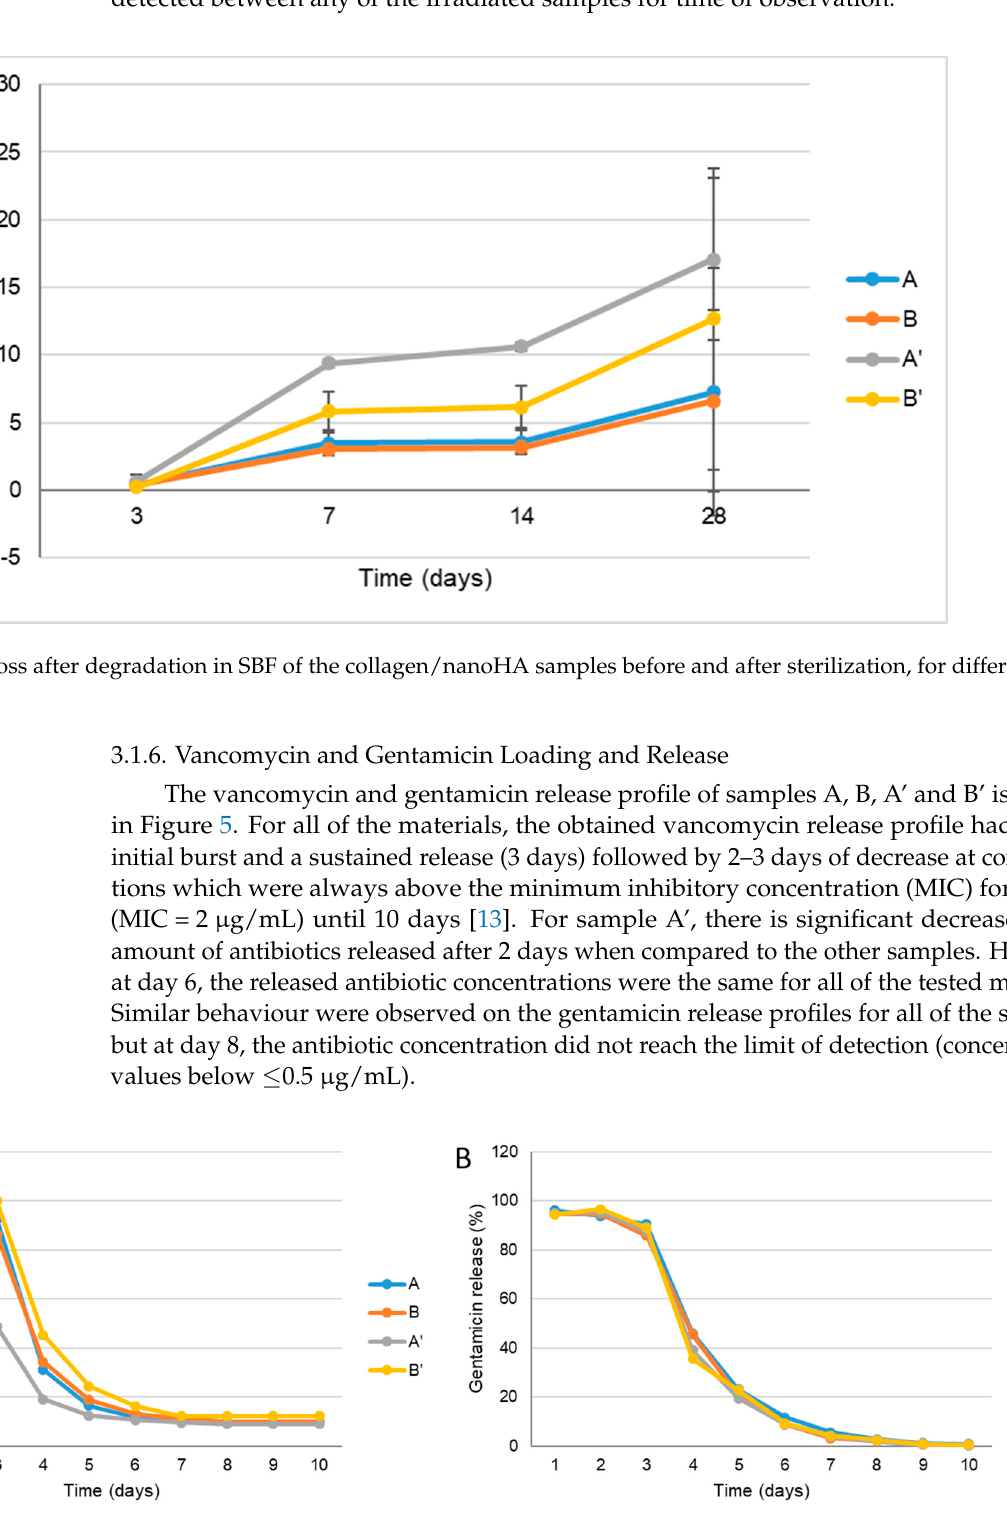
Figure 3. FT ‐ IR spectra of the Coll/nanoHA scaffolds produced with different collagens before (A and B) and after sterilization (A’ and B’).